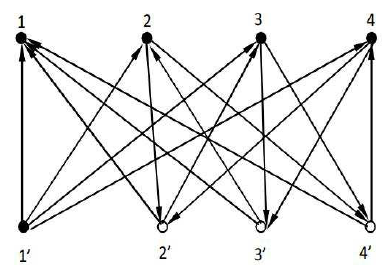
Figure 4. The bipartite zero forcing set of P .